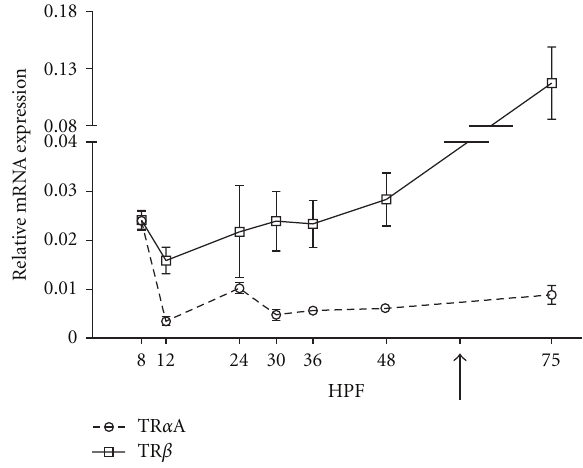
Figure 3: Expression of TR α A and TR β in whole zebrafish embryos during the first three days post fertilisation. Specific mRNA levels were measured by qRT-PCR and normalised against the housekeep- ing gene Elongation factor 1 α . Values represent the mean ± SEM for 3 independent samples (pools of 50–100 embryos) per stage. The arrow indicates the average time of hatching. HPF: hours post fertilisation. Data were taken from [7,